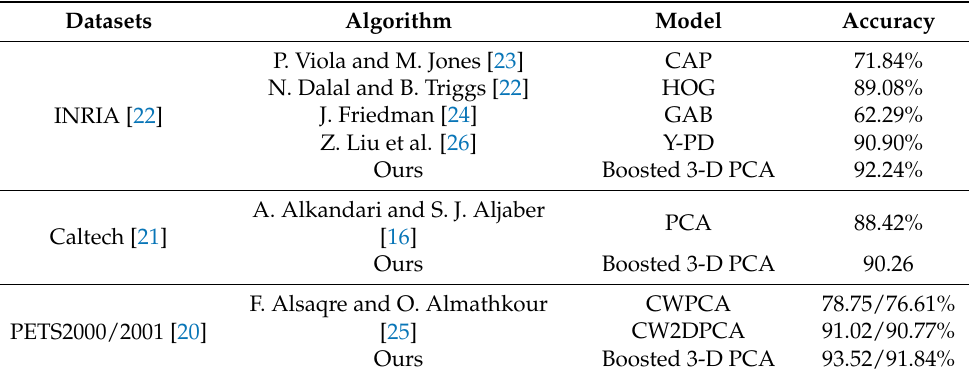
Table 1. Experimental results for benchmark datasets.